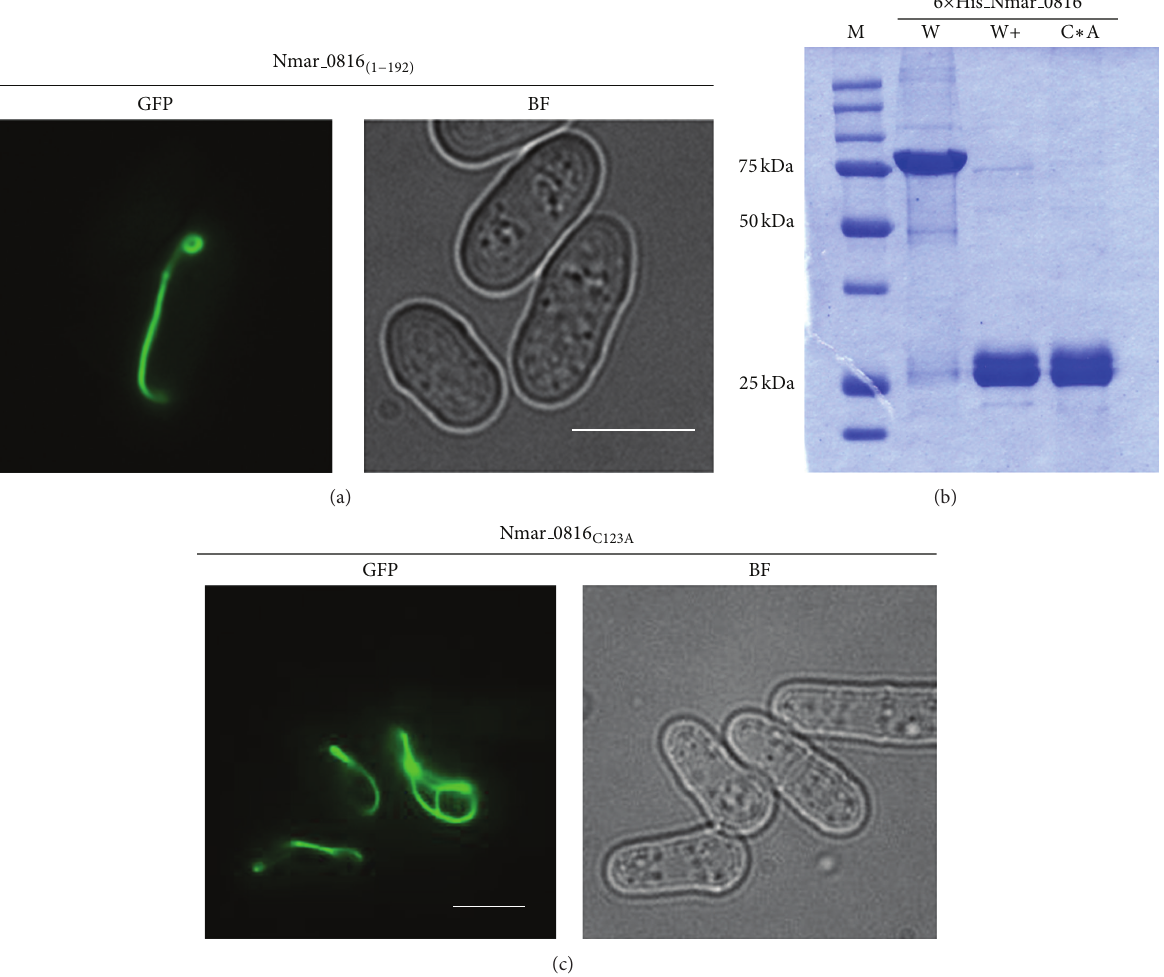
Figure 3: The core domain of the CdvB is necessary for Nmar 0816 polymer formation in yeast. (a) Images of yeast cells expressing -GFP. Scale bar: 7 𝜇 m. (b) Expression and purification of Nmar 0816 in E. coli . W: 6 × His-Nmar 0816, nonreducing Nmar 0816 (1 – 192) condition. W+: 6 × His-Nmar 0816, in the presence of 5% 𝛽 -mecaptoethanol. C ∗ A: 6 × His-Nmar 0186 -GFP. Scale bar: 5 𝜇 Images of yeast cells expressing Nmar 0186 C 123 A